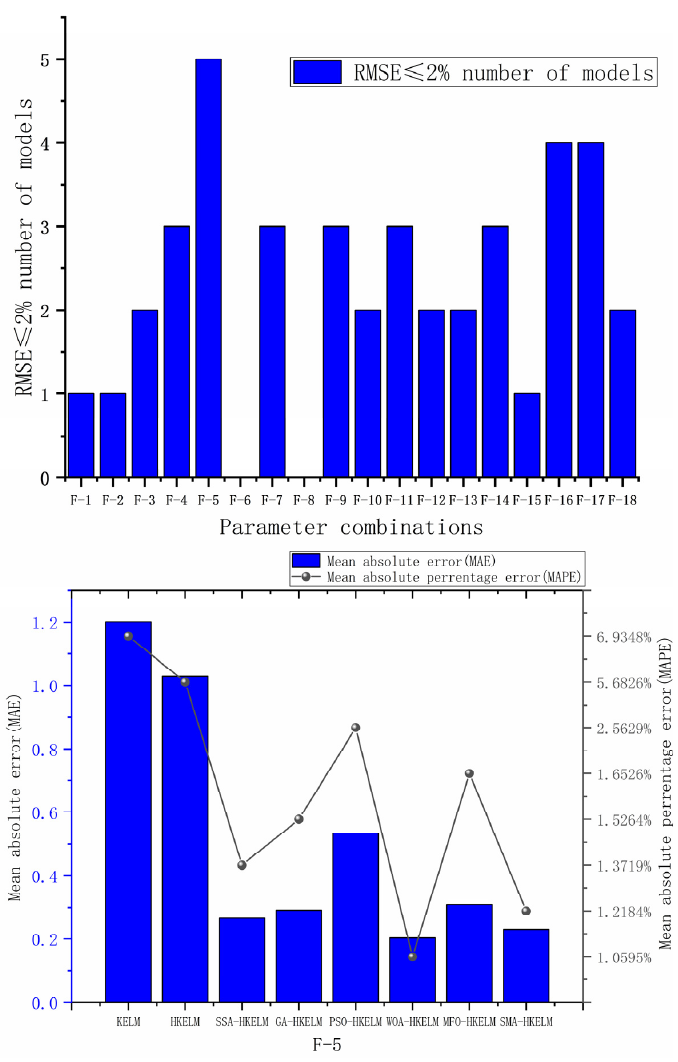
Figure 6. Results of each model.